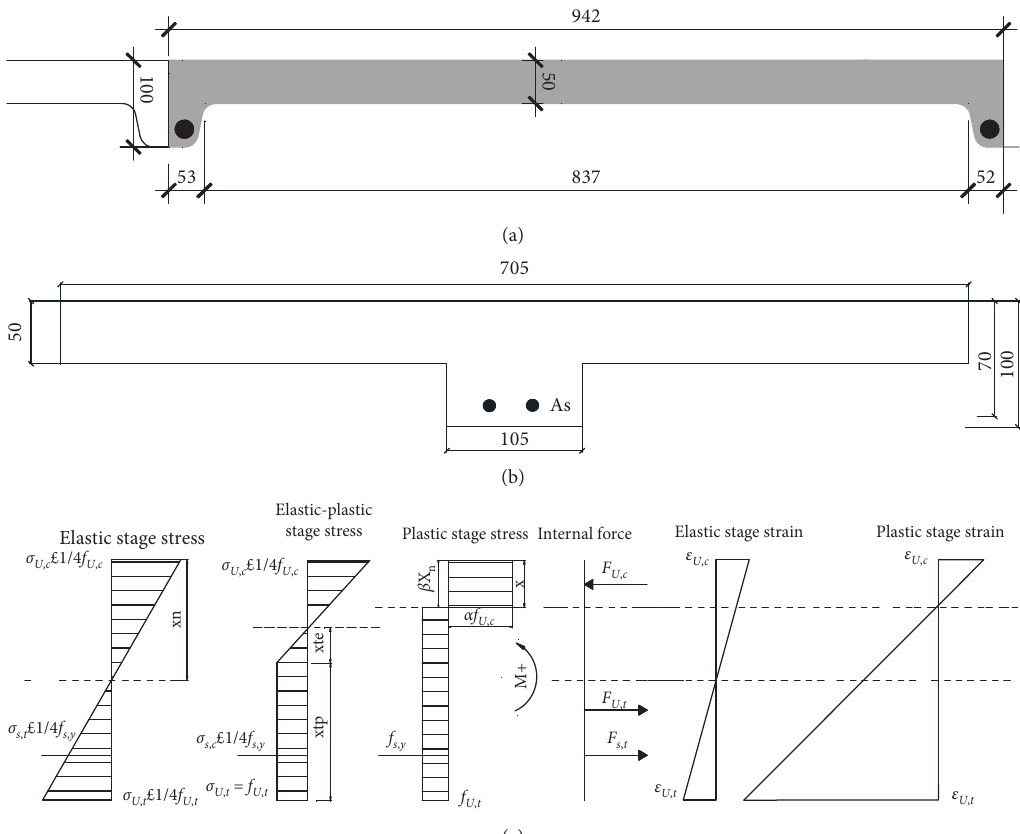
Figure 14: The theoretical calculation difficulty diagram. (a) Half longitudinal section (unit: mm). (b) Converted section (unit: mm). (c) Simplified calculation of the limit state